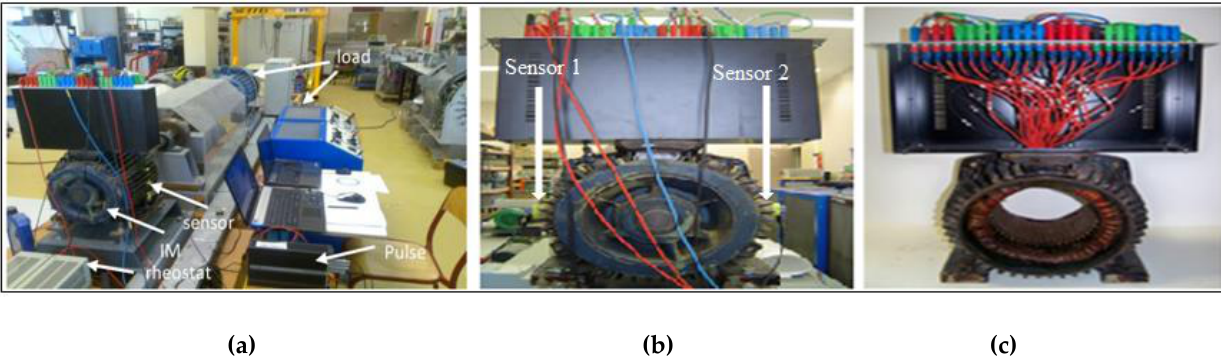
Figure 8. Experimental test bench with special induction machine modified to enable inter-turn short circuits ( a ) test bench, ( b ) flux sensors spatially shifted at 180°, ( c ) stator with a short circuit box and output connections.